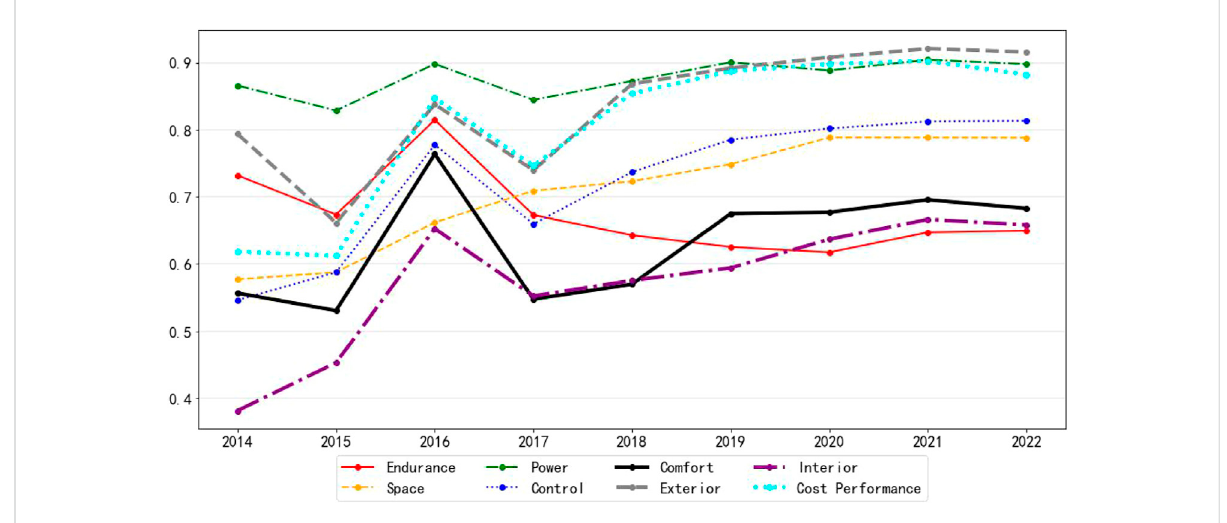
FIGURE 7 2014 – 2022 emotional trend